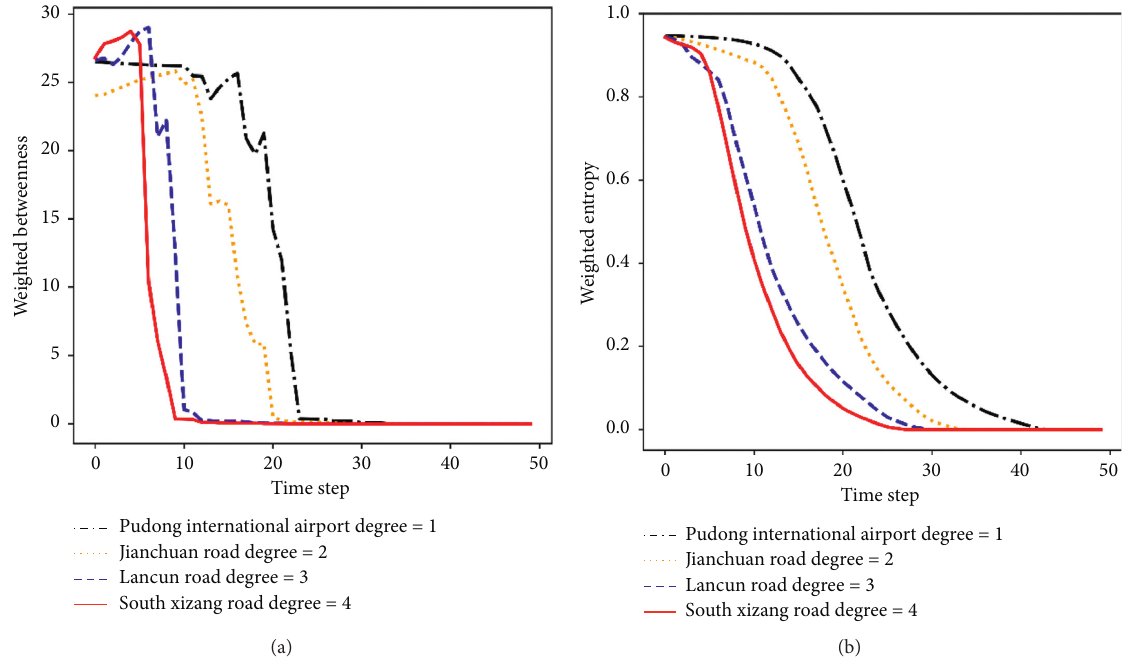
Figure 4: Changes of passenger-flow-weighted network reliability during cascading failure processes caused by stations of different degrees (a) for weighted betweenness and (b) for weighted